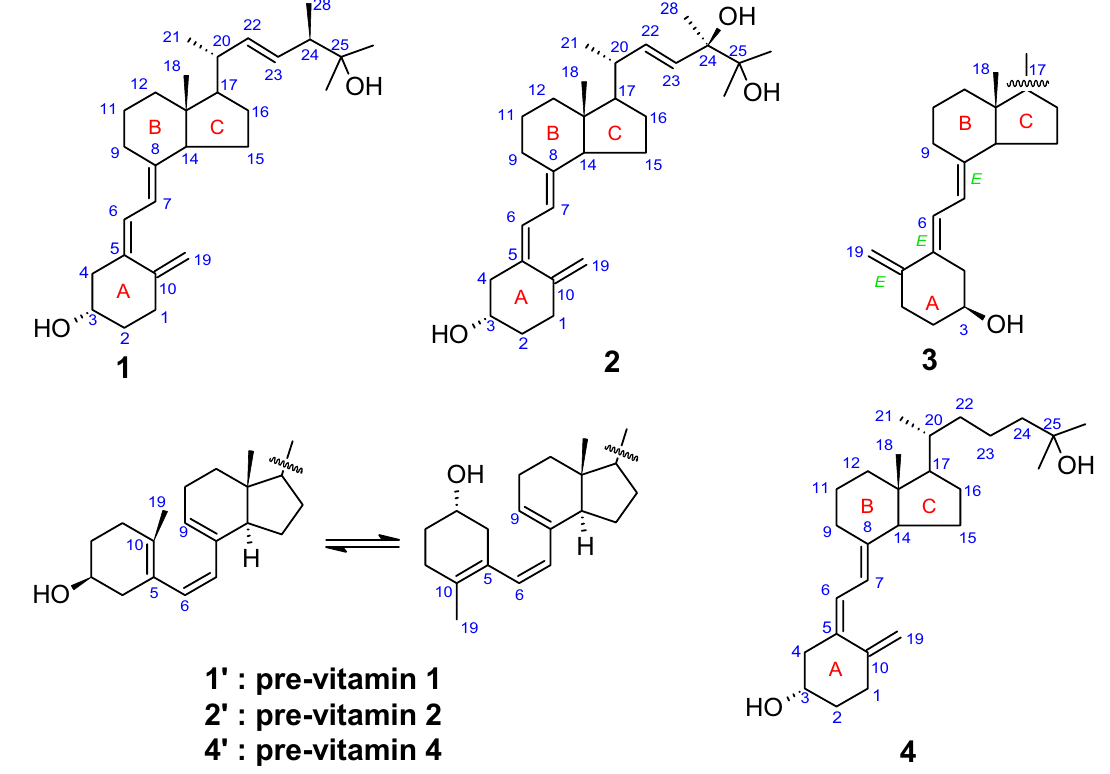
Figure 1. Structures of Vitamin D vitamers ((25-hydroxyvitamin D2 (1); 24 R ,25-dihydroxyvitamin D2 (2); 25-dihydroxyvitamin D3 (4)) and the corresponding isomerization pre-vitamin